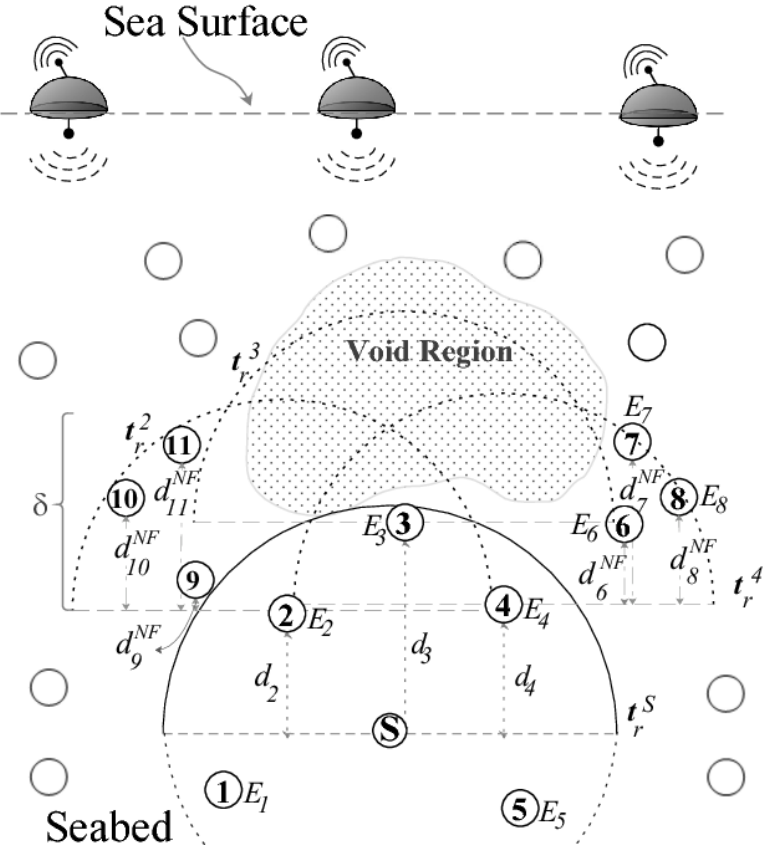
Figure 12. Holding time calculation parameters [52].